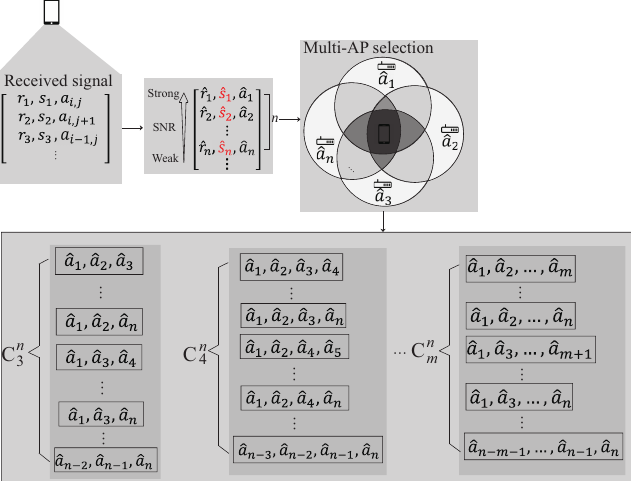
Figure 7. The multi-AP selection